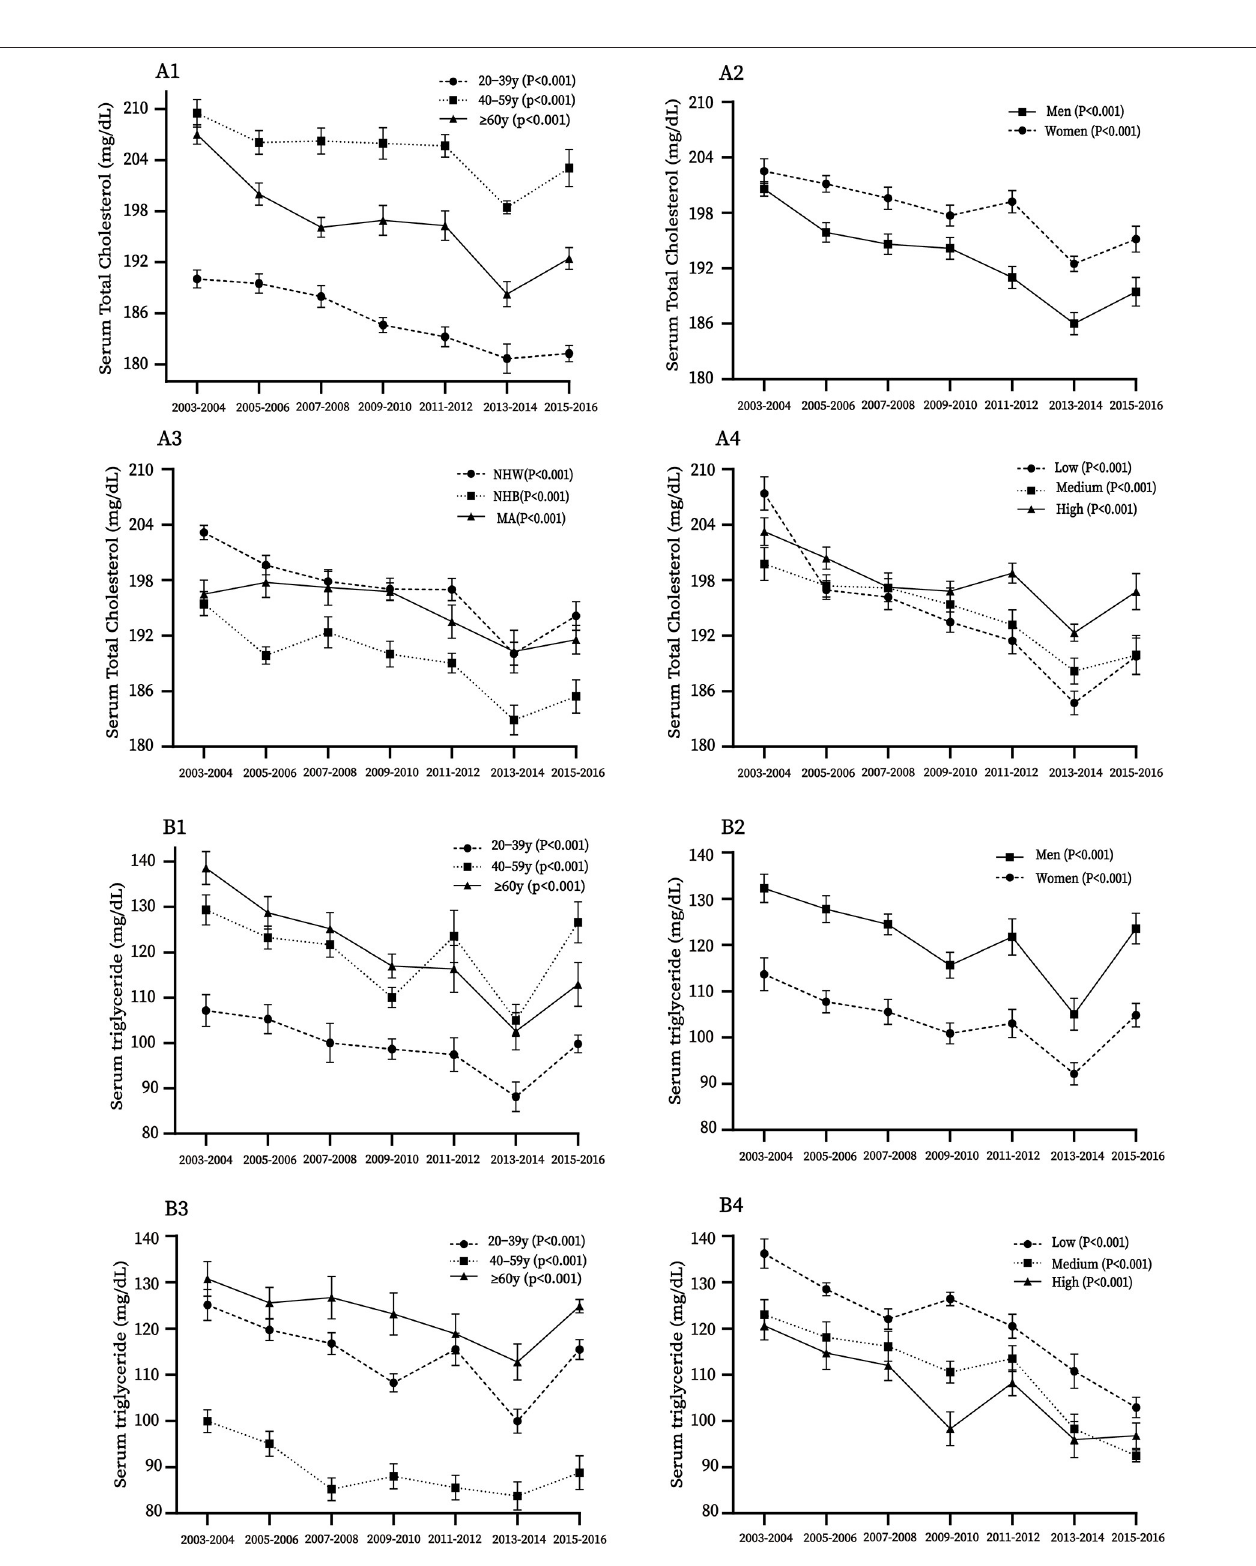
FIGURE 3 | Trends of concentrations of serum total cholesterol (A1–A4) and triglyceride (B1–B4) , by age, sex, race-ethnicity, and socioeconomic status (SS) among US adults from 2003 to 2016. MA, Mexican American; NHW, non-Hispanic white; NHB non-Hispanic black.